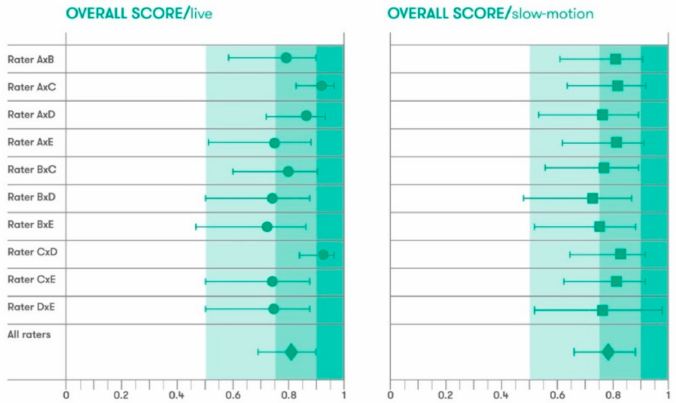
Figure 1. Inter-rater intraclass correlation coefficients (ICC) values of locomotor and ball skills subscales and overall